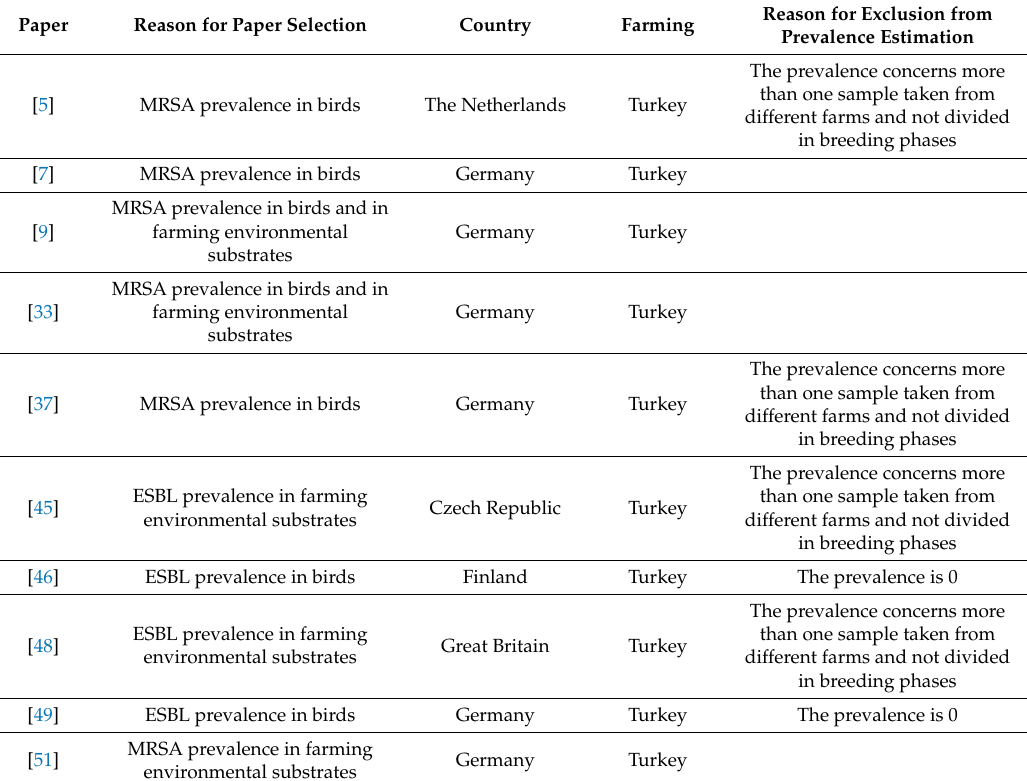
Table 3. Main characteristics of included papers for MRSA and ESBL prevalence in turkey farm workers.